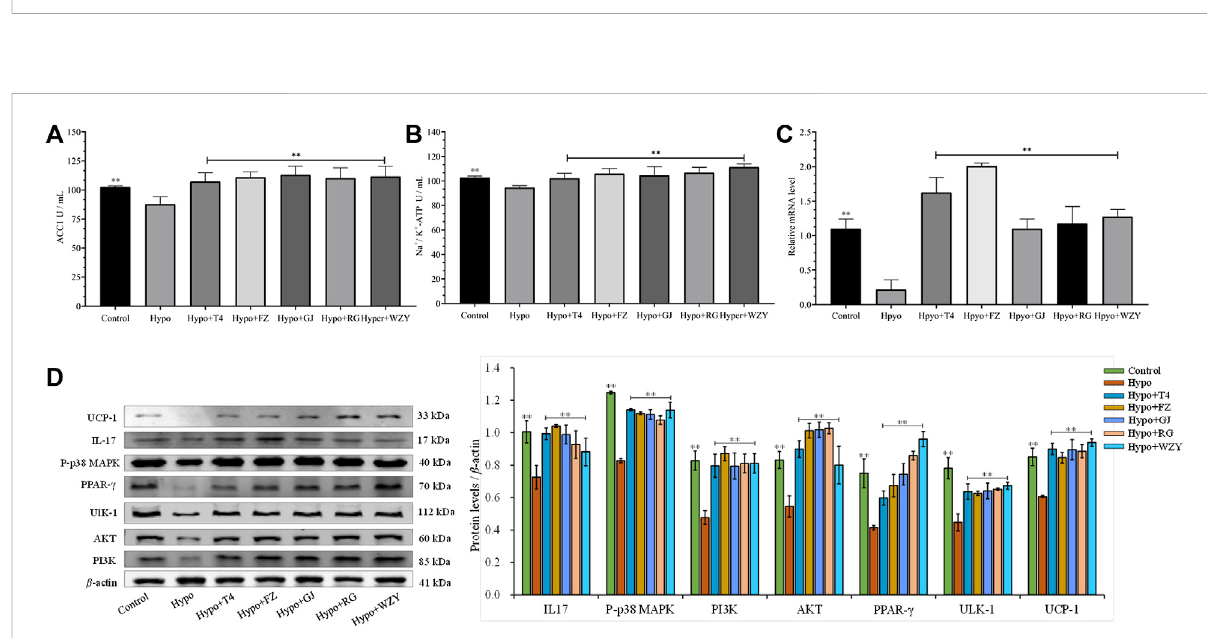
The levels of the ACC1 enzyme (A) , Na + /K + -ATP enzyme (B) ( n = 8) in the liver and the real-time PCR analysis of mRNA levels of UCP-1 in BATs fromthehypothyroid modelratusing NADPHastheinternalcontrol (C) ;theproteinexpression levelsofIL17, MAPK,PI3K, Akt, andULK-1 intheliver, and UCP-1 in BATs (D)